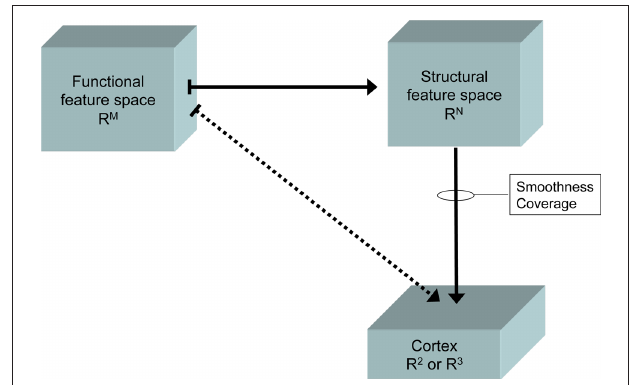
Figure 1 | Schematic drawing of the mappings between functional features space (e.g., stimulus features, movement parameters, cognitive operations, etc.), structural feature space (cell morphology, connectivity, neurotransmitter type, etc.), and cerebral cortex, modeled as two- dimensional sheet (r 2 ) or three-dimensional volume (r 3